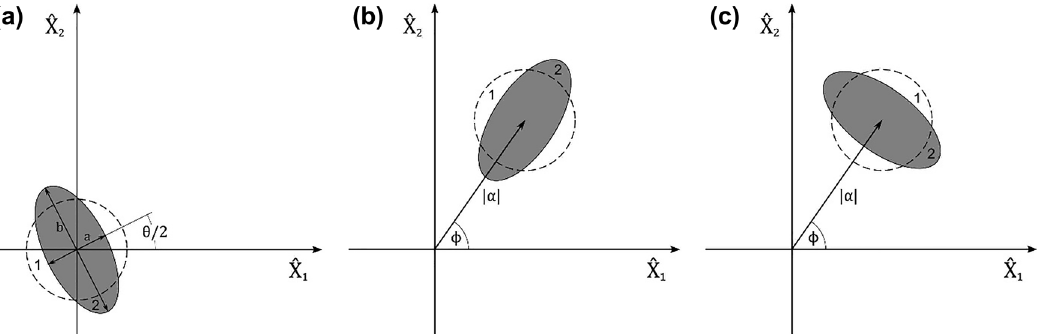
Figure 4: Quadrature-space representation of squeezed states. The quadrature circles and ellipses indicate the uncertainties in the field quadratures Δ X 1 , Δ X 2 . Vacuum and coherent states (1) have equal quadrature uncertainties. When these states are transformed to squeezed states the area of the uncertainty ellipse (2) is conserved [108]. (a) Vacuumstate(1)andsqueezedvacuumstate(2).(b)Brightphase-squeezedstate(2)generatedfromacoherentstate(1)withamplitude | α | and phase ϕ . (c). Bright amplitude-squeezed